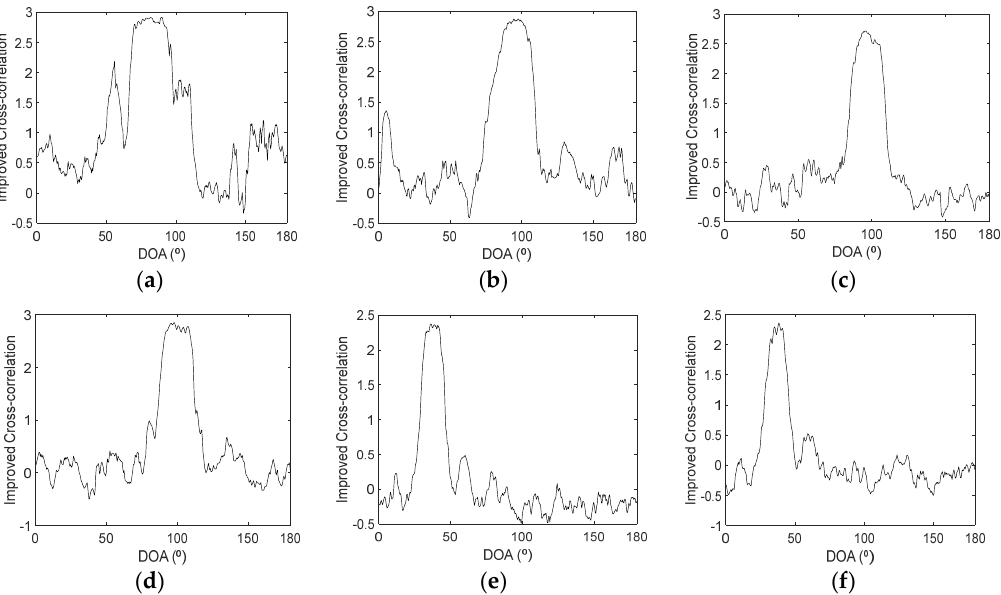
Figure 10. The DOA estimation results using the proposed method outdoors at distances of ( a ) 500 m, ( b ) 1000 m, ( c ) 1500 m, ( d ) 2000 m, ( e ) 2500 m, and ( f ) 3000 m.